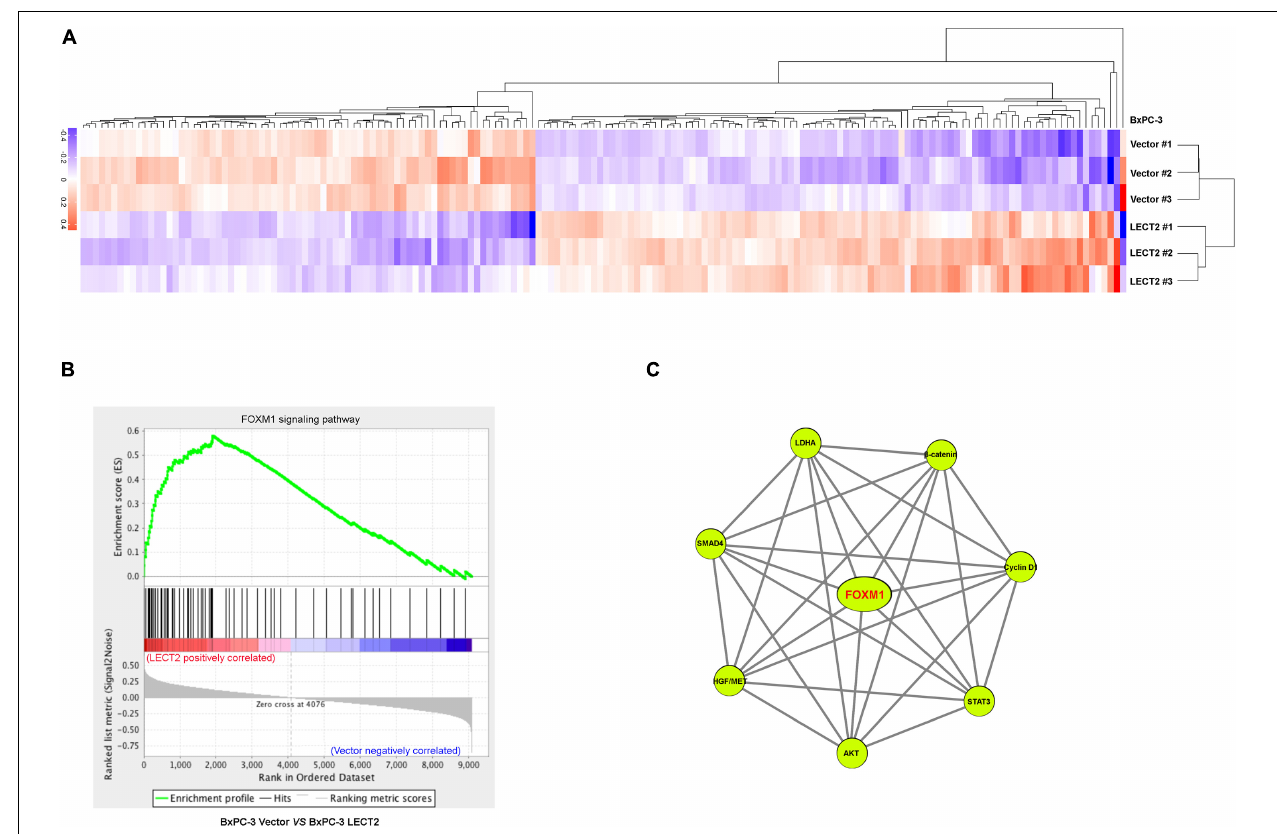
FIGURE 5 | LECT2 negatively correlates with the FOXM1 signaling pathway. (A) Heatmap summarizing genes that differentially expressed in BxPC-3 cells transfected with control or LECT2 vectors. Up-regulated genes were labeled in red, and downregulated genes were shown in purple. (B) Enrichment of the FOXM1 signaling pathway in Gene Set Enrichment Analysis (GSEA) of genes altered as described above. (C) Protein-Protein-Interaction Network, including the enriched genes in the FOXM1 signaling